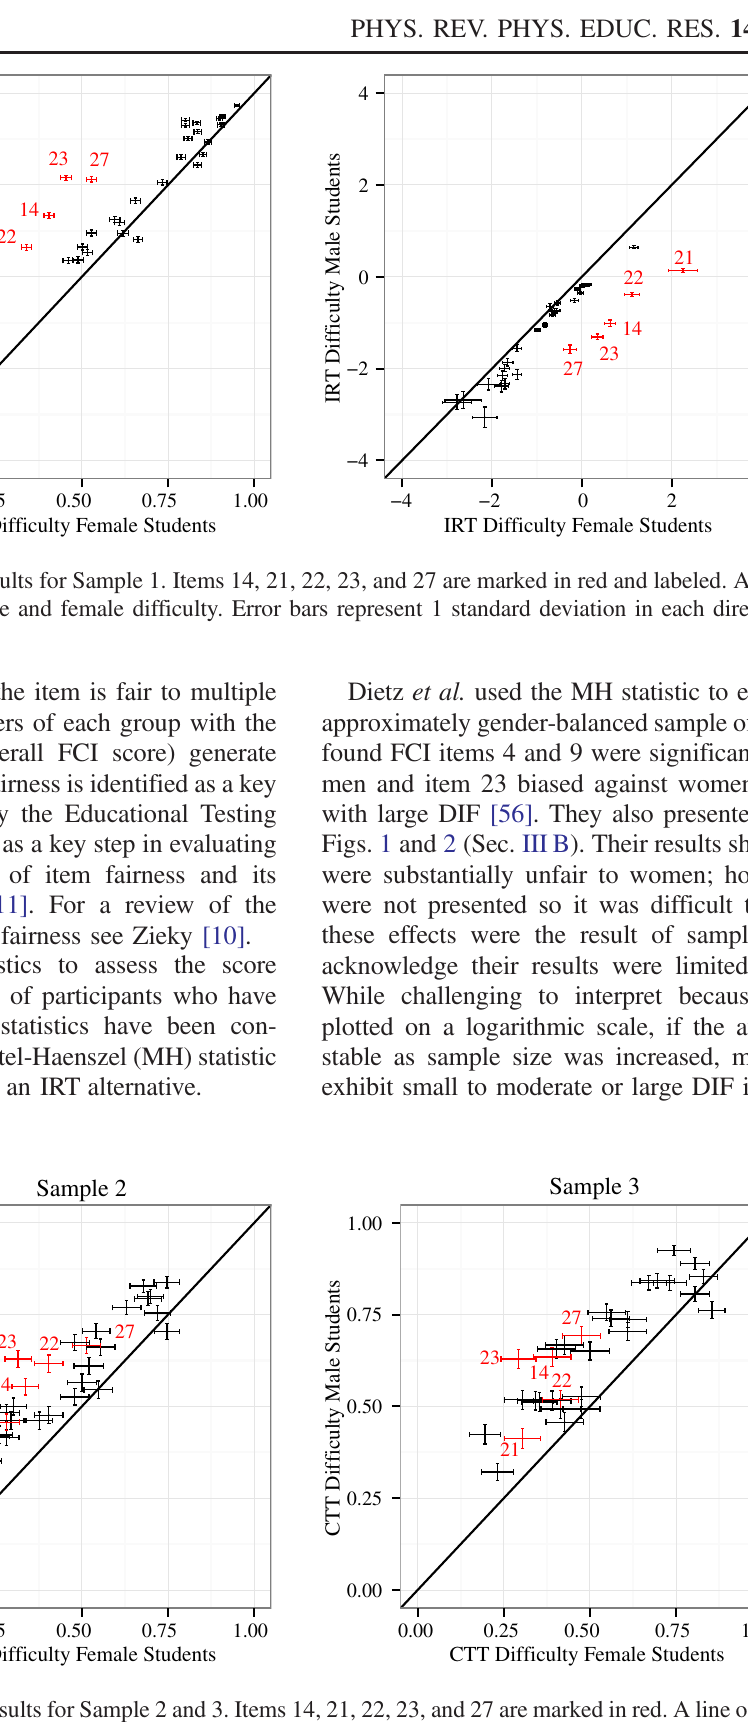
FIG. 2. CTT post-test difficulty results for Sample 2 and 3. Items 14, 21, 22, 23, and 27 are marked in red. A line of slope one is drawn to allow comparison of male and female